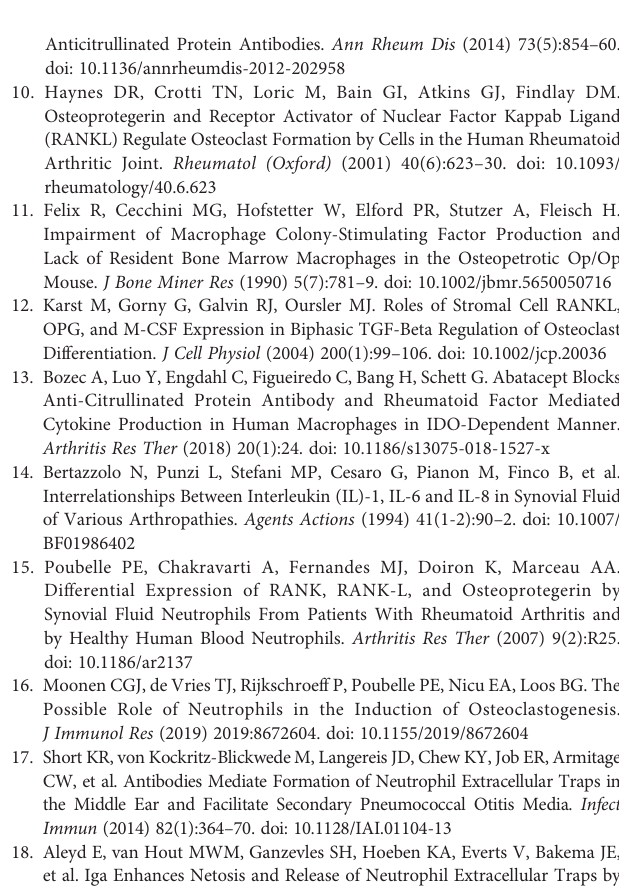
Supplementary Figure 1 | Correlation between NET release after stimulation of neutrophils with immune complexes isolated from synovial fl uid of RA patients with OD values of (A) ACPA IgA (left) or ACPA IgG (right), (B) anti-CarP IgA (left) or anti- CarP IgG (right) and (C) RF IgA measured in synovial fl uid of RA patients. Supplementary Figure 2 | (A) Correlation between monocyte IL-6 and IL-8 release induced by immune complexes of RA SF. (B, C) Correlation between monocyte IL-6 release and (B) (left) anti-CarP IgA levels or (right) RF IgA, or (C) (left) ACPA IgG levels and (right) anti-CarP IgG levels. (D) Correlation between monocyte IL-8 release and (left) anti-CarP IgA levels and (right) anti-CarP IgG levels. Supplementary Figure 3 | (A) Gating strategy to check the purity of sorted osteoclasts. (left) Location of osteoclasts (OCs) on forward-side scatter area with adjusted laser settings to visualize large cells; (middle) viability of the OCs; (left) CD14 negative OCs. (B) Multinucleated osteoclast TRAcP expression (purple) 24 hours after sorting [Blue (DAPI) =